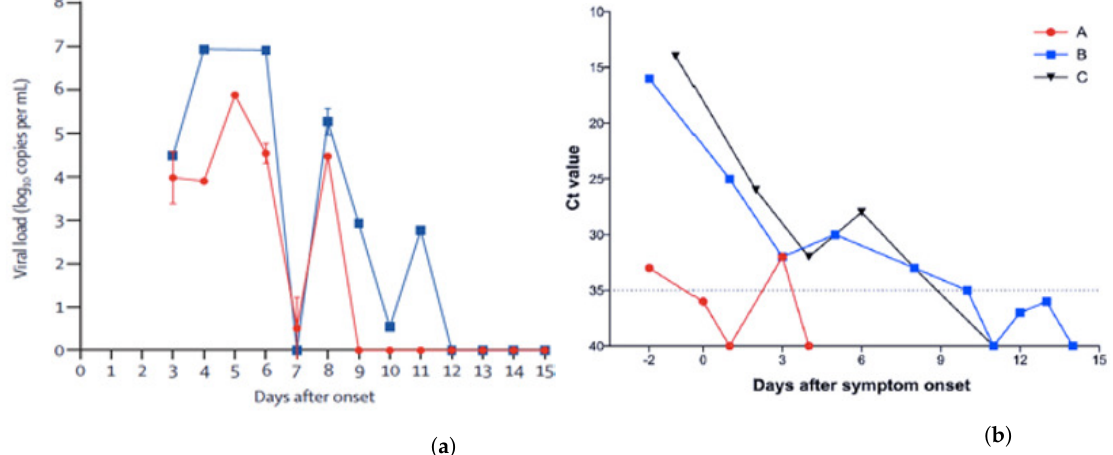
Figure 2. Viral load in COVID-19 real patients [14]. In ( a ), the red curve corresponds to the throat swab and the blue curve corresponds to the sputum. In ( b ), the curves correspond to several patients (A), (B), and